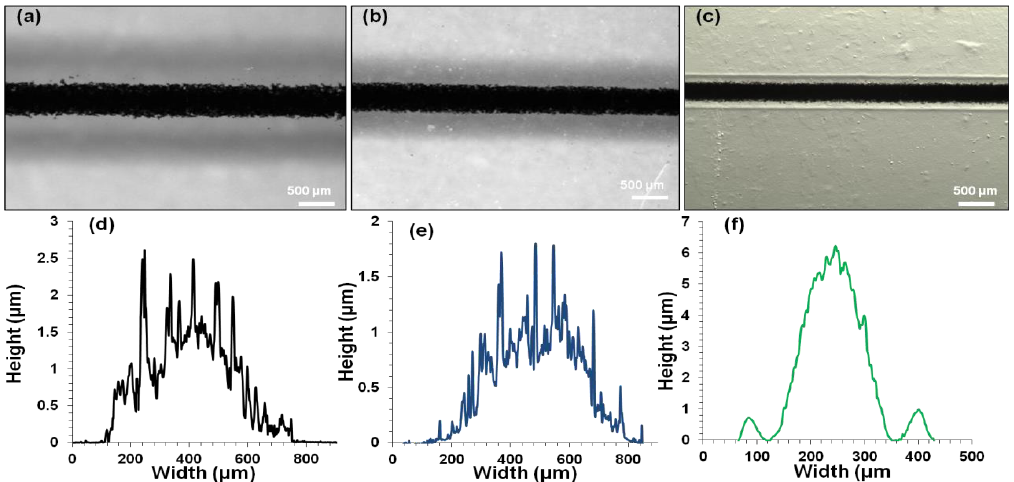
Figure 8. ( a – c ) Microscopy images and ( d – f ) profilometry curves of G-MWNT one printed layer on glass, PET, and IC film substrates, respectively. Area under the curve represents the cross-sectional area.